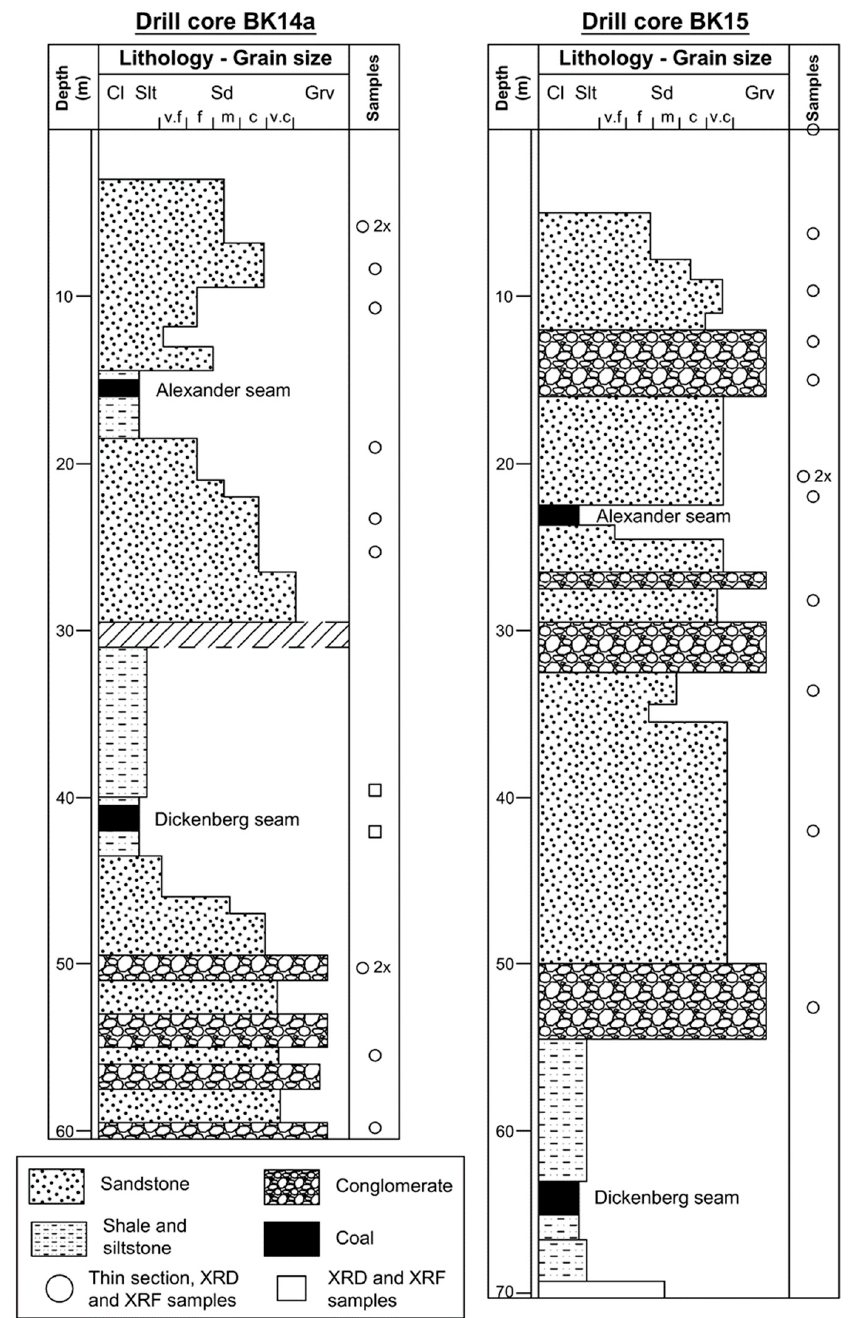
Figure 3. Stratigraphic columns of the two core ‐ samples recovered in the area. The sketch includes lithology and location of the samples analyzed in this paper. Cl = clay, Slt = silt, Sd = sand (v.f: very fine, f: fine, m: medium, c: coarse, v.c.: very coarse), Grv =